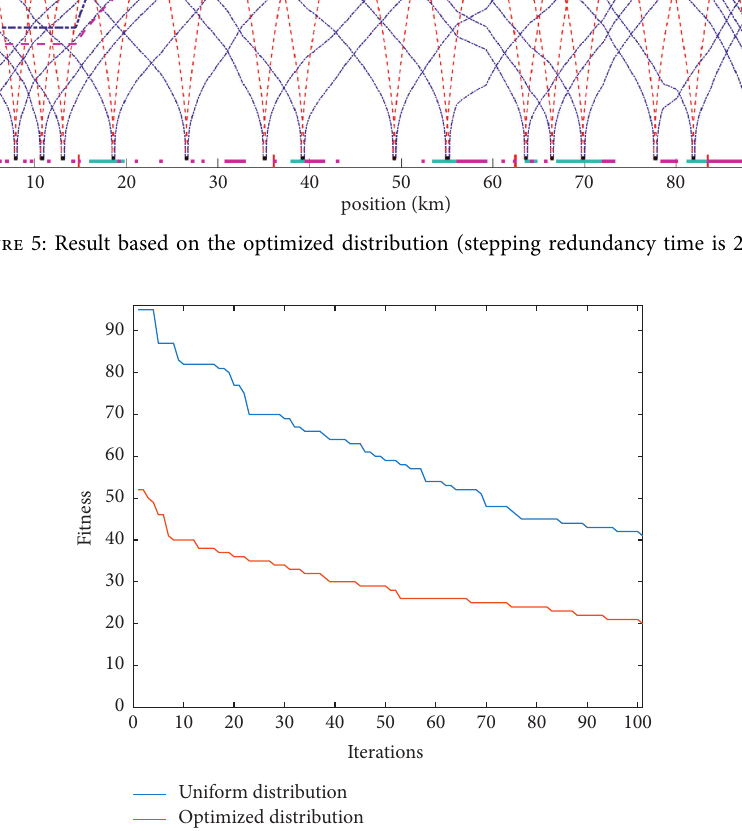
Figure 6: Comparison of iterative curves of different distribution methods. The data in the chart is acquired after averaging the 30 times of